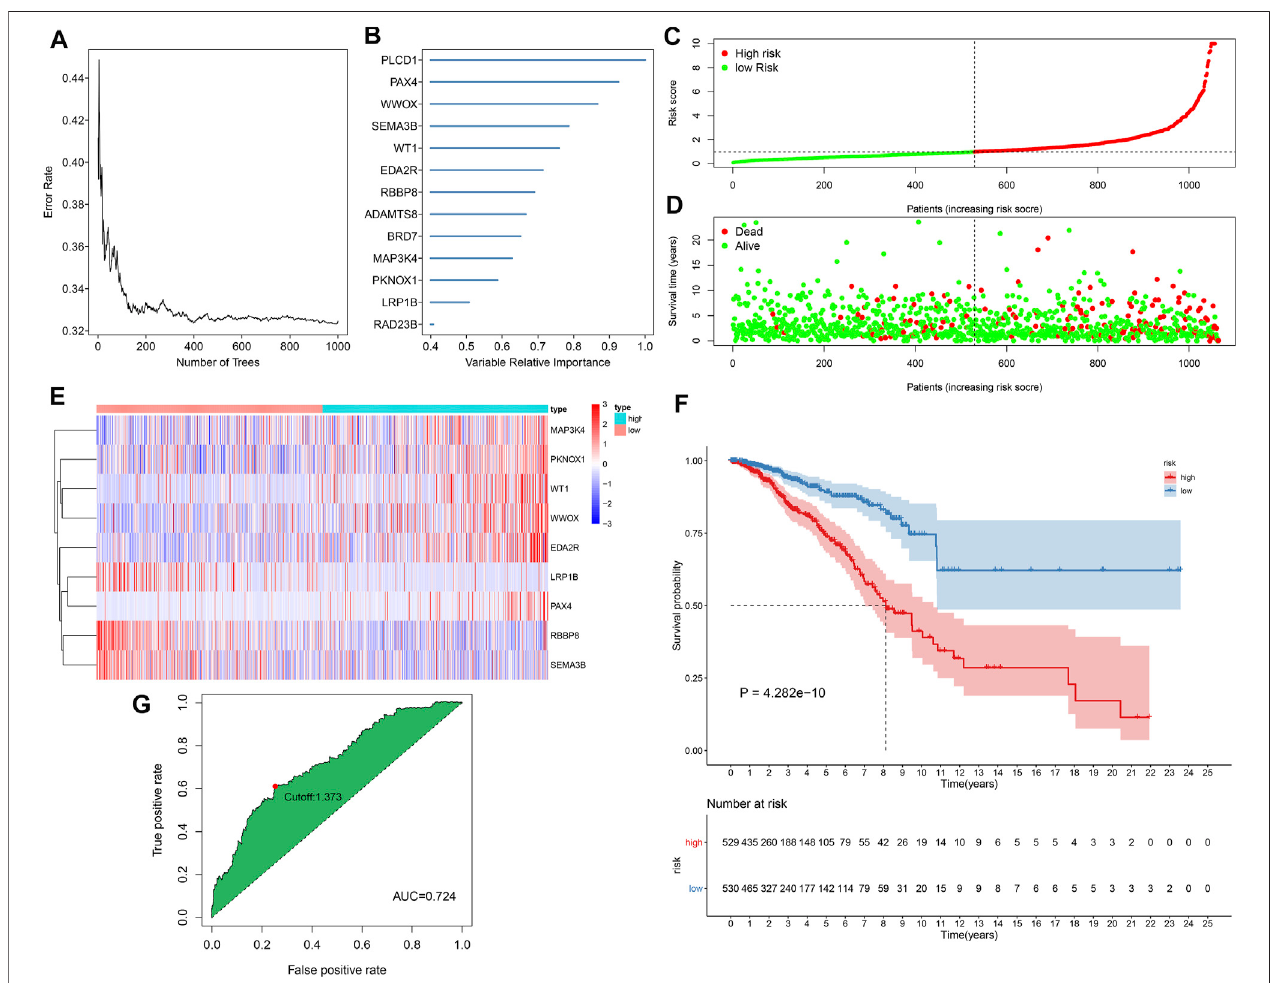
FIGURE 1 | Development of a tumor suppressor gene (TSG)-based prognostic classi fi er for breast cancer in the Cancer Genome Atlas (TCGA) cohort. (A) Correlationbetweennumberofclassi fi cationtreesanderrorrate. (B) TherankofcharacteristicTSGsaccordingtotherelativeimportance. (C) Thedeterminationofhigh- and low-risk subgroups according to the median risk score (RS) (vertical dotted line). (D) Distribution of survival status in high- and low-risk subgroups. (E) Heat map visualizing the mRNA expression of each characteristic TSG in high- and low-risk subgroups. (F) Kaplan – Meier curves of overall survival (OS) and log-rank test of high- and low-risk subgroups. (G) Receiver operating characteristic (ROC) curve of the TSG-based prognostic classi fi er.